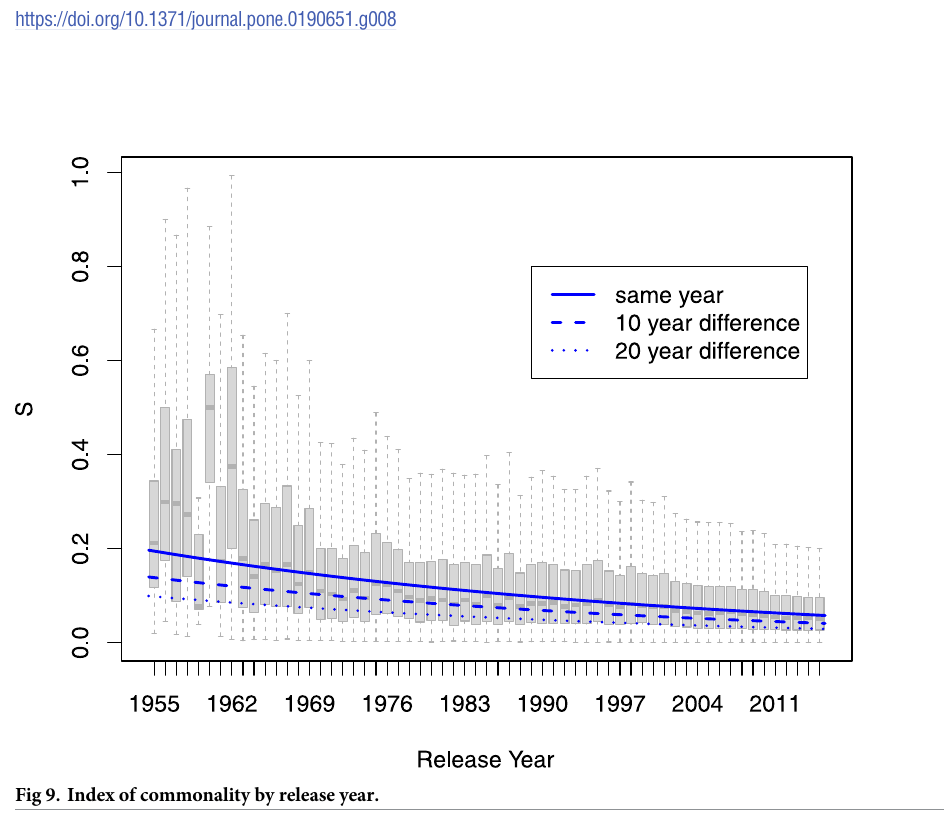
Fig 9. Index of commonality by release